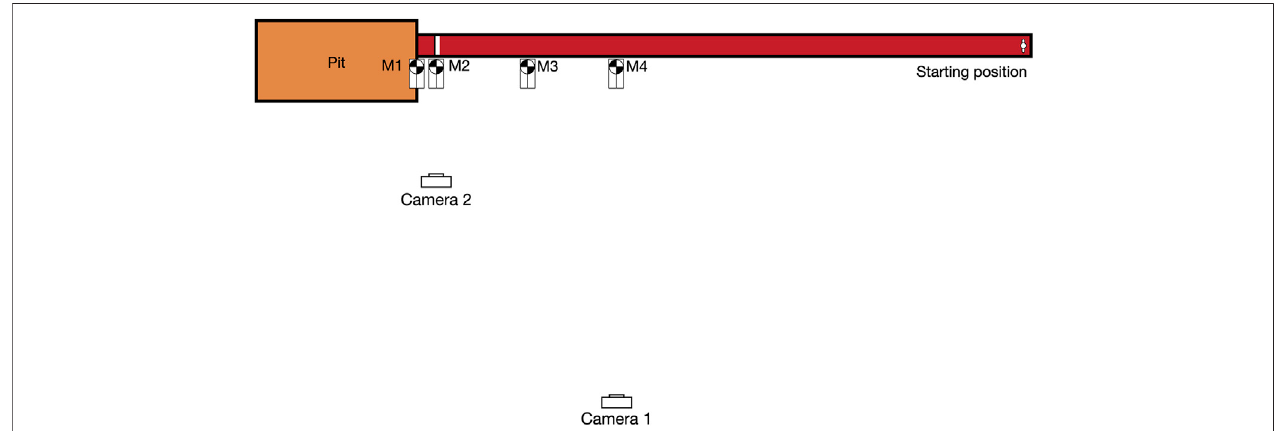
FIGURE 2 | The protocol of the Knowledge-Based Smart Trainer system for testing.